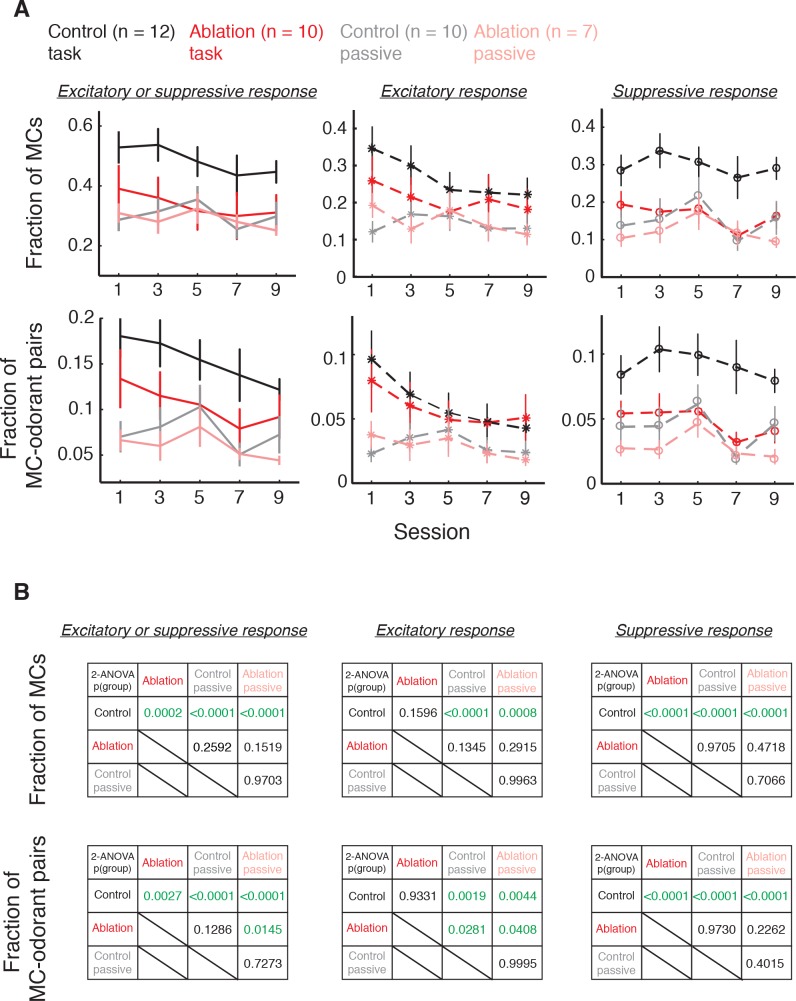
Fractions of responsive MCs during difficult discrimination task and passive exposure.Control behavior: n = 12; ablation behavior: n = 10; Control passive: n = 10; ablation passive: n = 7. (A) Overlay of Figures 5A–C and 7A–C. Mean ±S.E.M. (B) P values of comparisons between each pair of groups for total, excitatory and suppressive response fractions. P values: two-way ANOVA, group effect. Green indicates statistical significance.